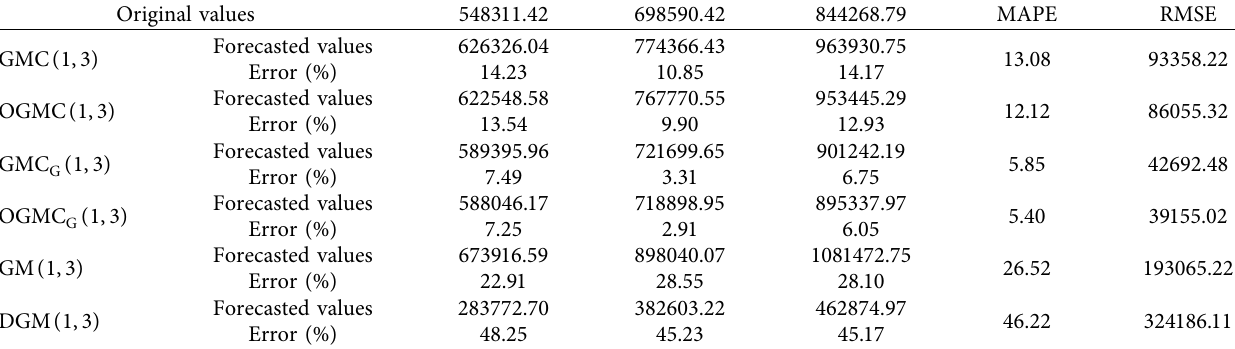
Table 6: The forecasted results and the values of three indices measuring accuracy by six competing models in case